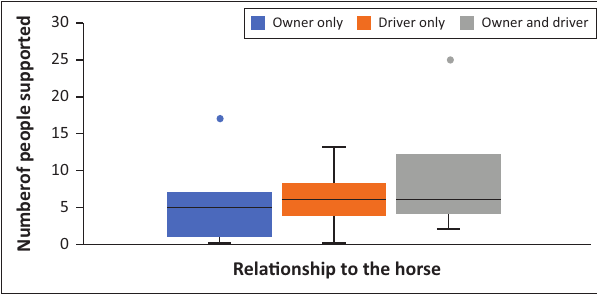
FIGURE 1: Boxplots to show the relationship between the participant’s relationship to their horse and the number of people they support. Boxes represent the range of number of people supported between the first and third quartiles with the median indicated by the bar running through the box. The whiskers represent the minimum (below) and maximum (above) number of people and outlier results are indicated by dots separate to the